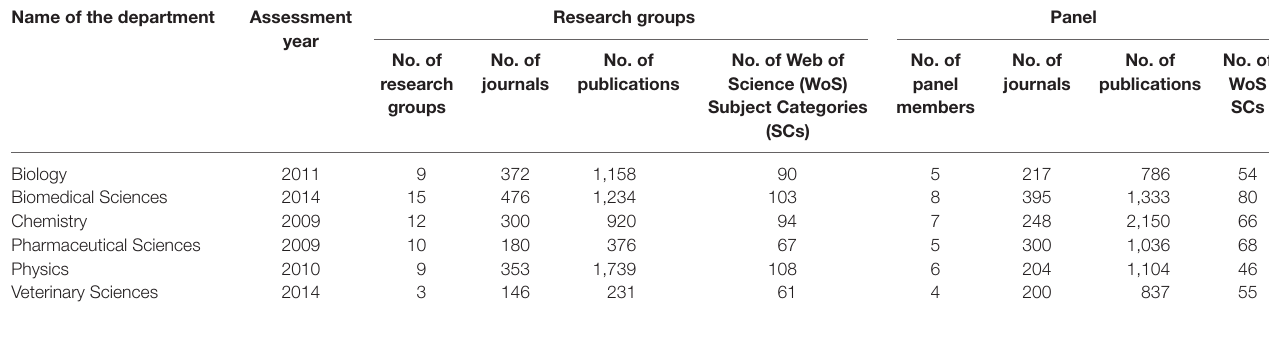
Table 1 | Publication statistics of the research groups and